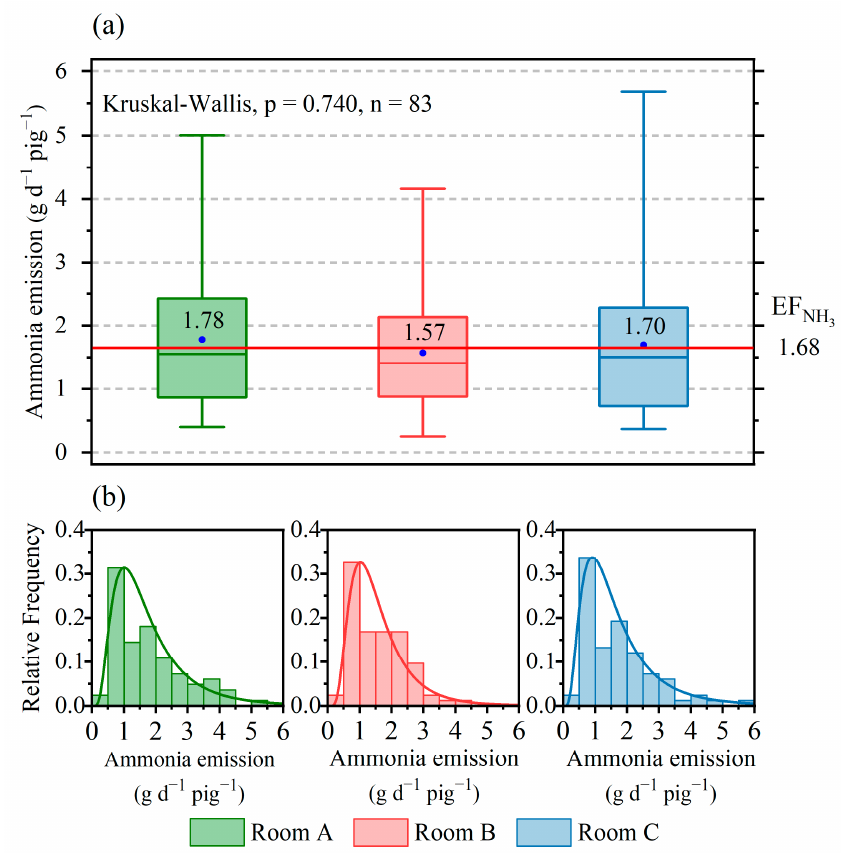
Figure 7. ( a ) Box plots and ( b ) distribution curves of daily ammonia emission in each of the three rooms (n = 83). The boxes in ( a ) represent the 25–75% range of samples, and the whiskers show the range within 3 interquartile range. The horizontal line represents median. Each blue dot is the mean of daily emissions in each room. As a result, the Kruskal–Wallis test showed no significant difference between the mean ammonia emission of the three rooms ( p -value = 0.740).